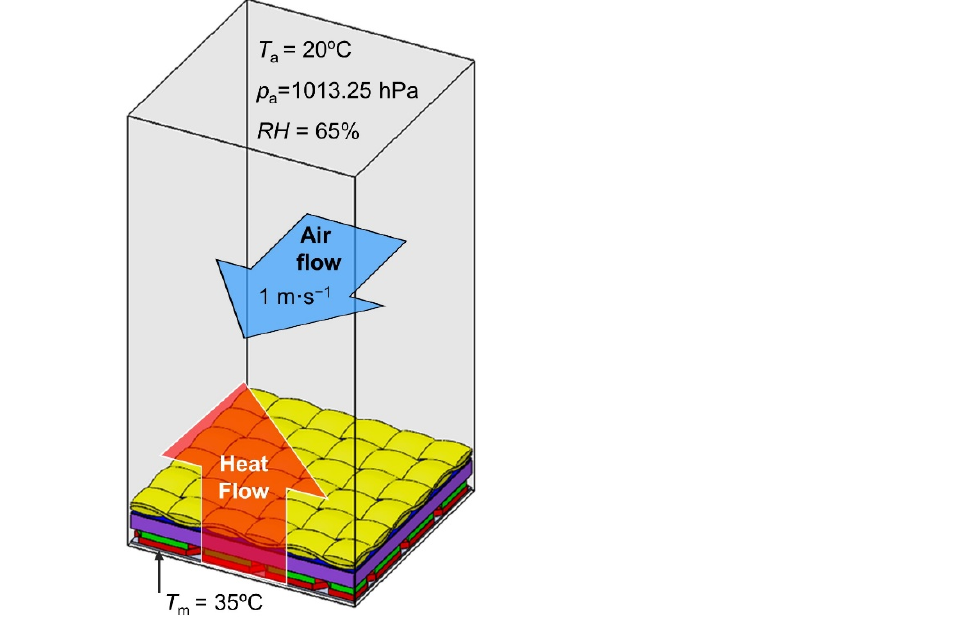
Figure 6. Conditions of simulations inside computational domain with dimensions of 10 mm × 10 mm × 20 mm.